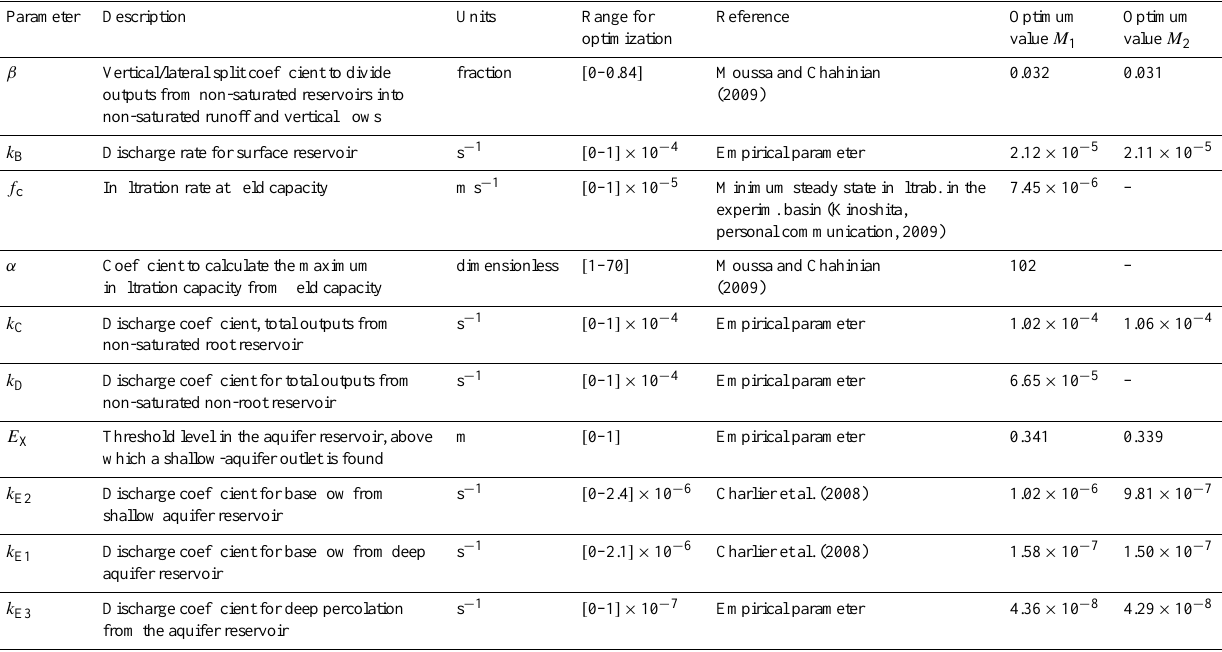
Table 2. Parameter description, range for optimization, optimized value and range for sensitivity analysis. M 1 : original 10-parameter model, M 2 : simplified 7-parameter